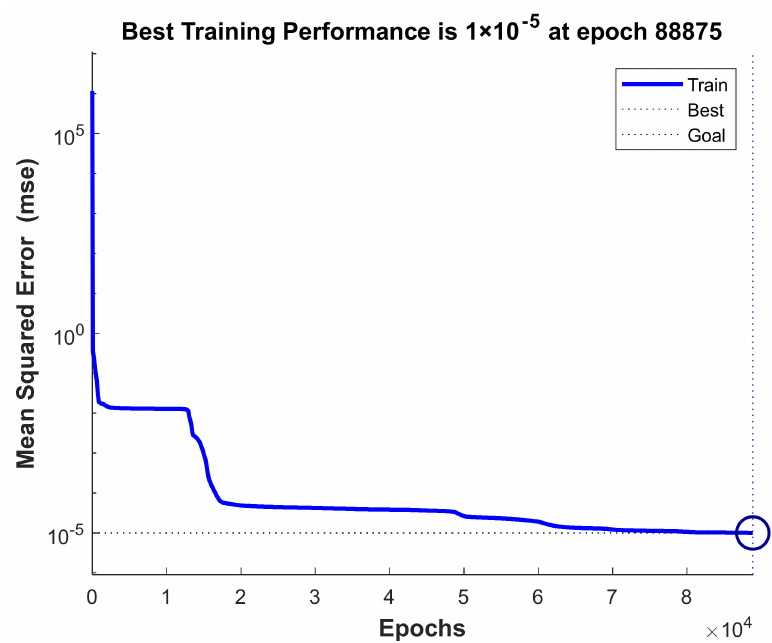
Figure 3. Performance of the proposed ANN